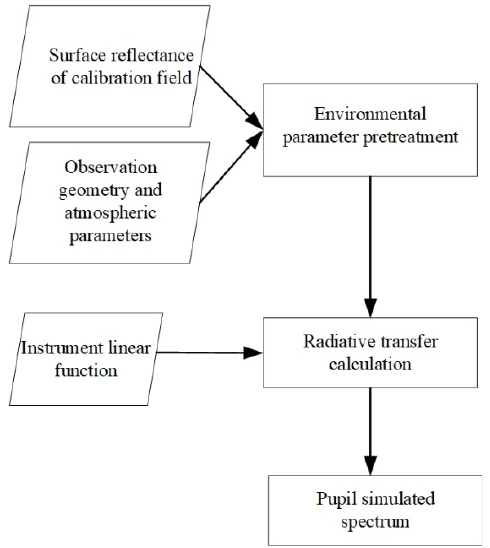
Figure 16. Flow chart of simulated spectrum calculation.